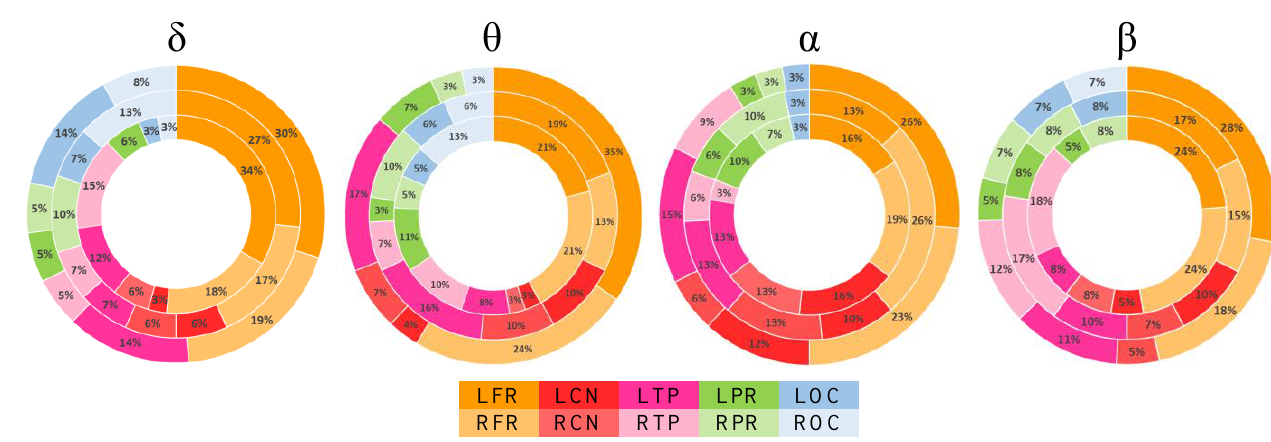
Figure 5. Regional proportion (percentage) of rich-club regions for the TD (outer ring), ADHD I (middle ring), and ADHD C (inner ring) groups in each frequency band.